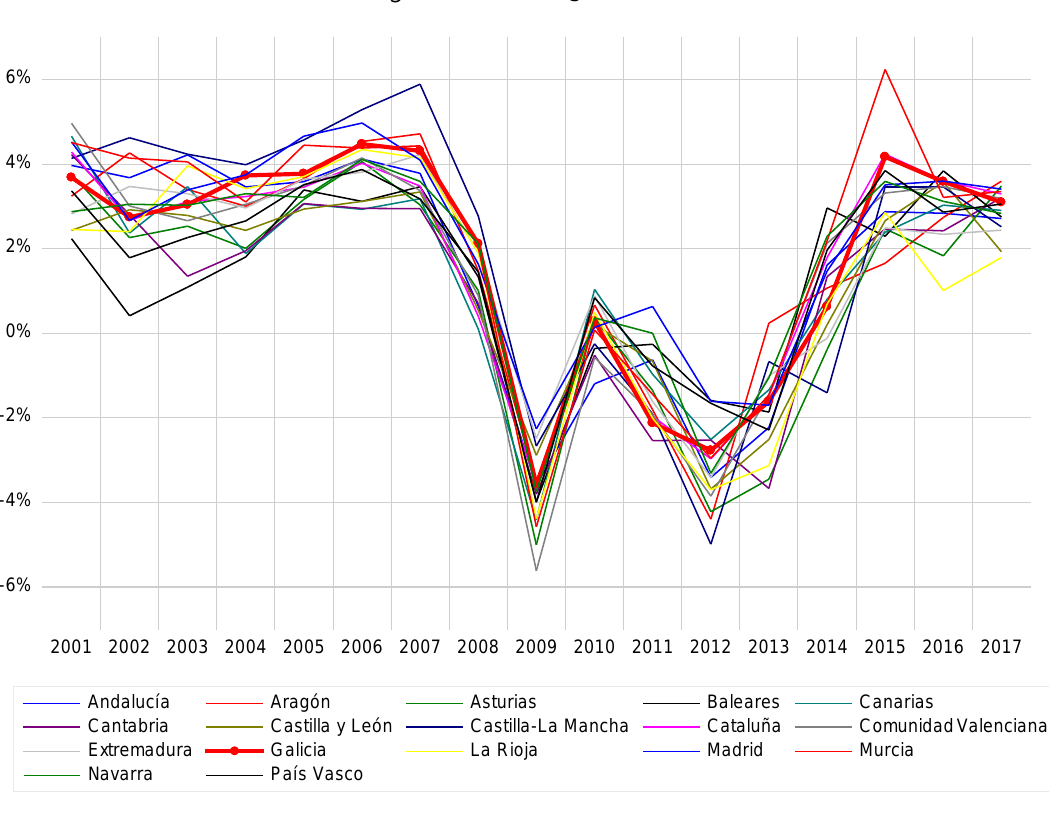
Figure 1 : GDP real growth